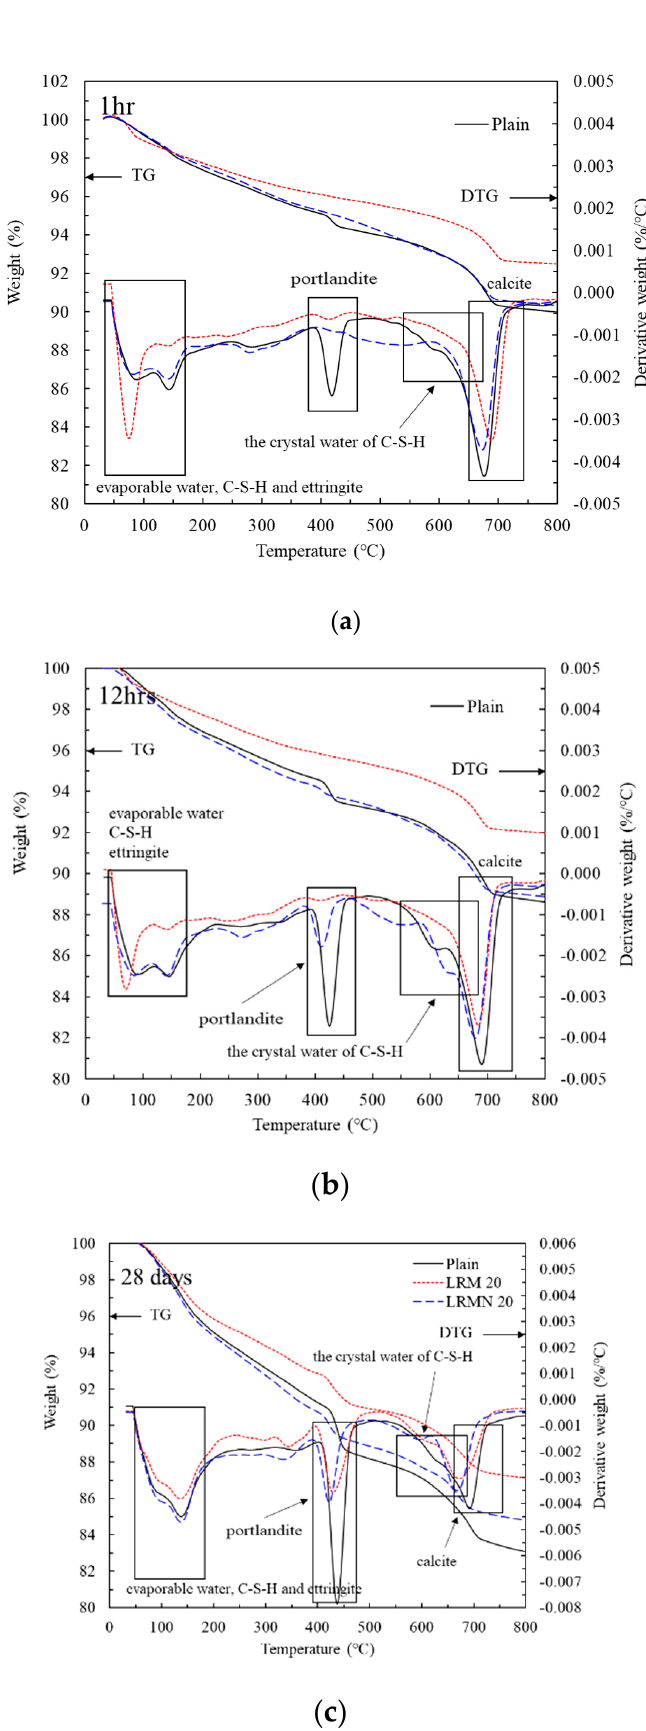
Figure 10. TG-DTG curves of the cement paste after aging for ( a ) 1 hr, ( b ) 12 hr, and ( c ) 28 days.